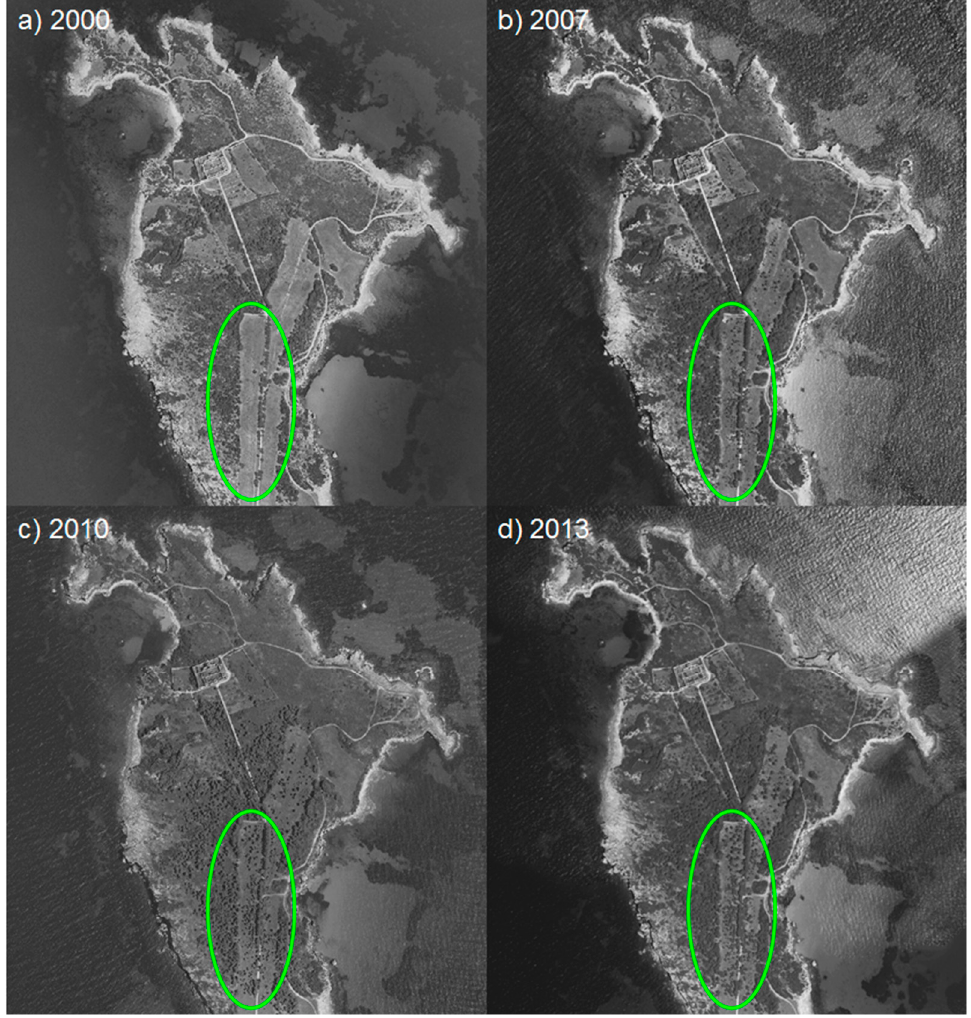
Figure 6. Visual comparison of the digital aerial orthophotos for a northern area of Pianosa Island (marked in green) based on images by Regione Toscana–SITA: Cartoteca for the years ( a ) 2000, ( b ) 2007, ( c ) 2010 and ( d )